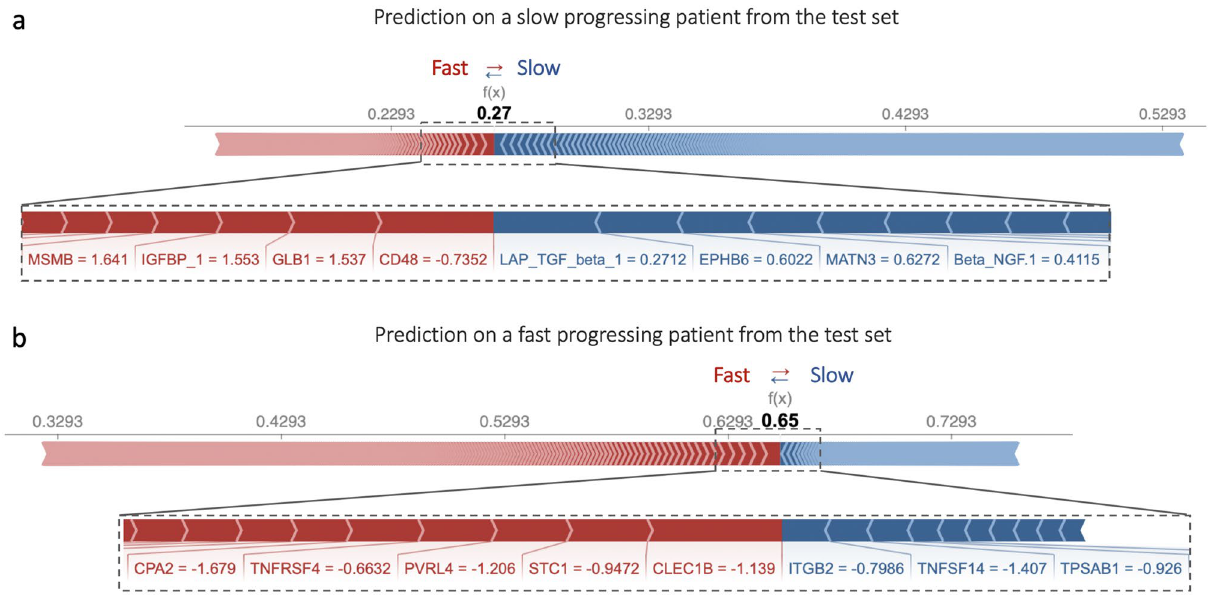
Figure 3. Shapley additive explanations (SHAP) analysis results for the model interpretability. For local interpretability figure shows two correctly classified patients from the test data in order to explain why each case receives its prediction and the contributions of these biomarkers. Note that the values indicated per biomarker are actual scaled values taken as input features by the prediction model. The model output values (0.27 and 0.65 respectively) are the predicted probability values for each observation (patient), which are not altered by the SHAP method. The width of the bar per feature corresponds to SHAP values indicating feature importance and the direction of the prediction. ( a ) The first patient received a score of 0.27, which is below the cut-off value of 0.5, and was thus classified as slow progressing. ( b ) Conversely, the second patient received a score of 0.65 and was classified as fast-progressing. Each observation (patient) gets its own set of SHAP values. Biomarkers in red contribute to the prediction being higher (Fast progressing, closer to 1), while features in blue push the value down towards the slow progressing group (0). SHAP summary plot shows us a birds-eye view of feature importance and how each biomarker drives the prediction (Fig.